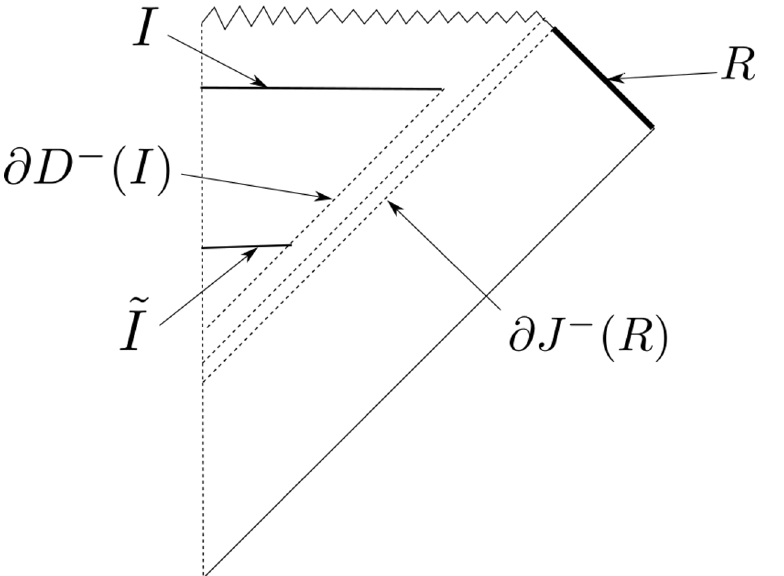
Figure 3 : An evaporating black hole in asymptotically Minkowski spacetime. Radiation region R has an island I . Also shown are the boundary of the causal past of R , the boundary of the past domain of dependence of I , and an earlier time representative ˜ I of I . This is a counterexample to the claim that the existence of a region satisfying conditions